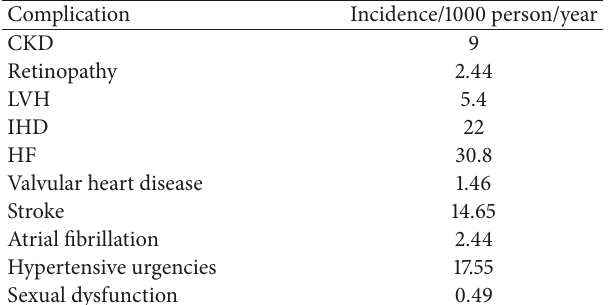
Table 2: The incidence rate of TOD in hypertensive patients’ 1000/person/year. A person-time analysis.